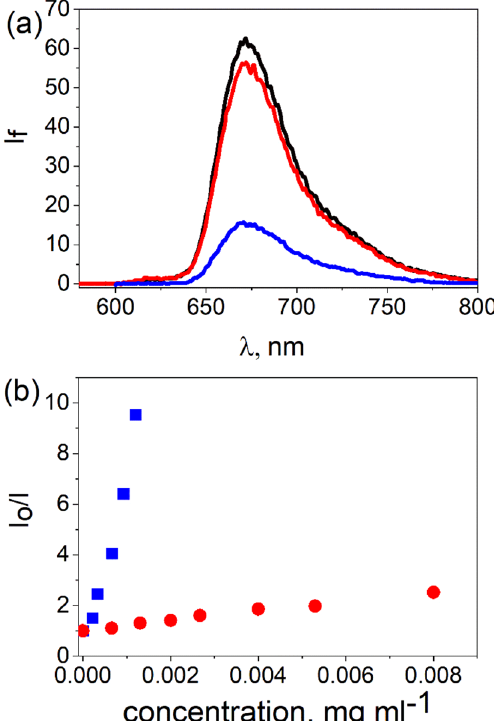
Figure 4. ( a ) Quenching of the fluorescence of 2.0 µ M TPPH (black) recorded after the addition of 6.9 × 10 − 3 mg ml − 1 of an aqueous suspension of GO (red) and RGO (blue). Spectra were corrected for the inner filter effect. ( b ) The relationship between fluorescence intensity I 0 / I ( I 0 = Intensity without GO or RGO, I = Intensity after addition of GO or RGO) and GO (red) or RGO (blue) concentration.